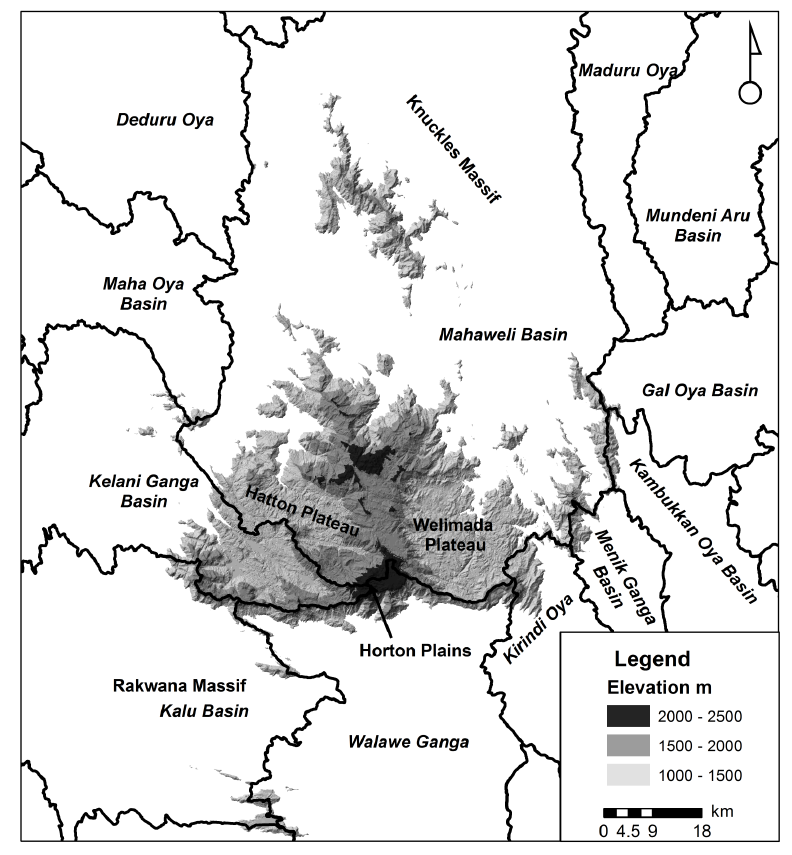
Figure 1: Montane and sub-montane elevation regions of the hill country of Sri Lanka.